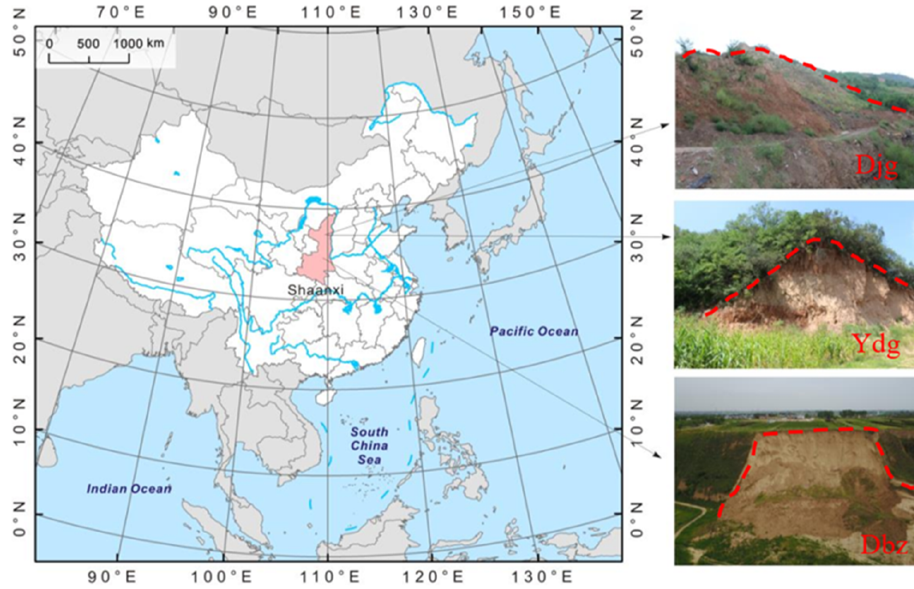
Figure 1. Location of study sites and some views of landslides (after Hu et al., 2018). Notes: dashed red lines in Fig. 1 represent the landslide